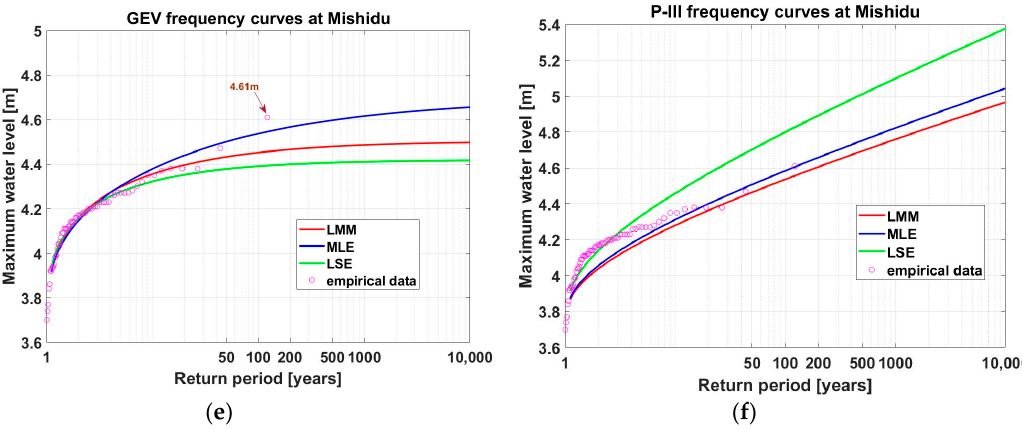
( e ) ( f ) Figure 4. Best-fit curves for three parameter estimation methods (LMM, MLE and LSE) for the three locations, for the GEV and P-III distributions. ( a ) best-fits curves for GEV at Wusongkou; ( b ) best-fits curves for P-III at Wusongkou; ( c ) best-fits curves for GEV at Huangpu Park; ( d ) best-fits curves for P-III at Huangpu Park; ( e ) best-fits curves for GEV at Mishidu; ( f ) best-fits curves for P-III at Mishidu.